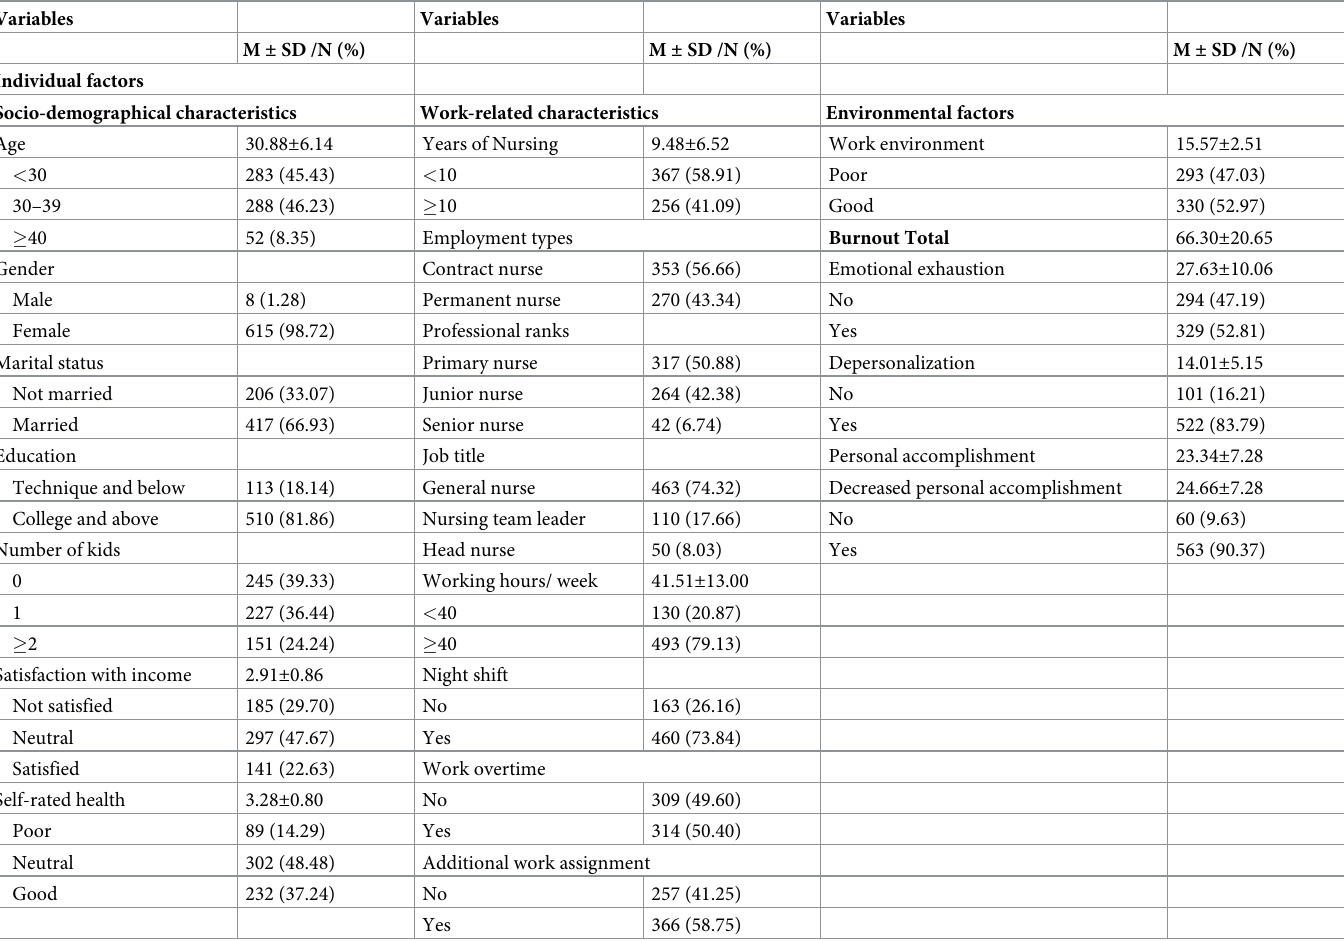
Table 1. Individual characteristics of the study population (N =